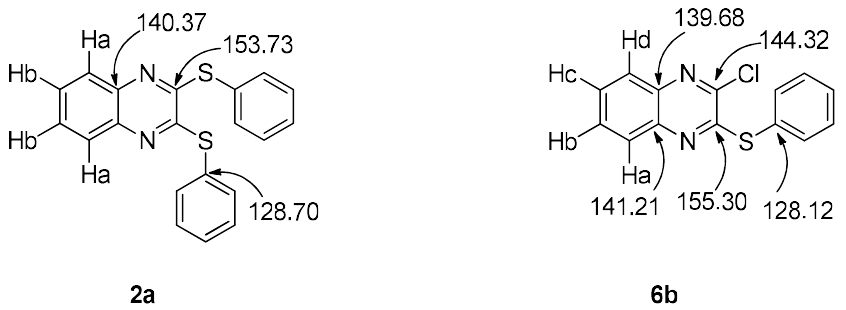
Figure 2. Quinoxaline moiety of 2a showed only two protons and two quaternary carbon in NMR. 6b showed four different types of protons and four different quaternary carbons, which correspond to its quinoxaline moiety.